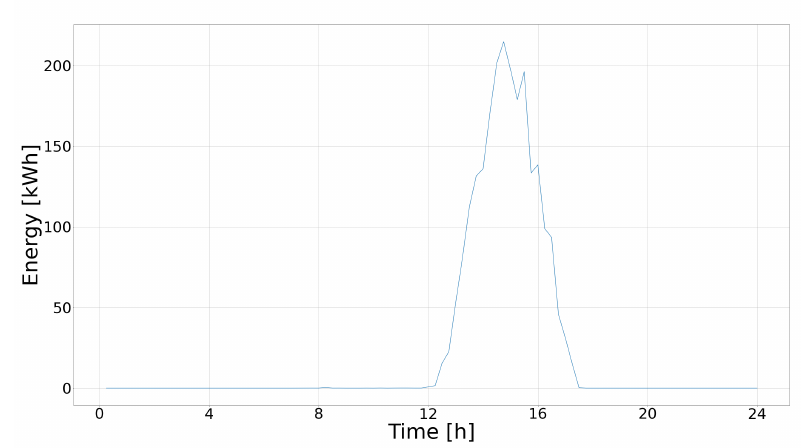
Figure 16. Average M R over time with PV scenarios scaled up by a factor of